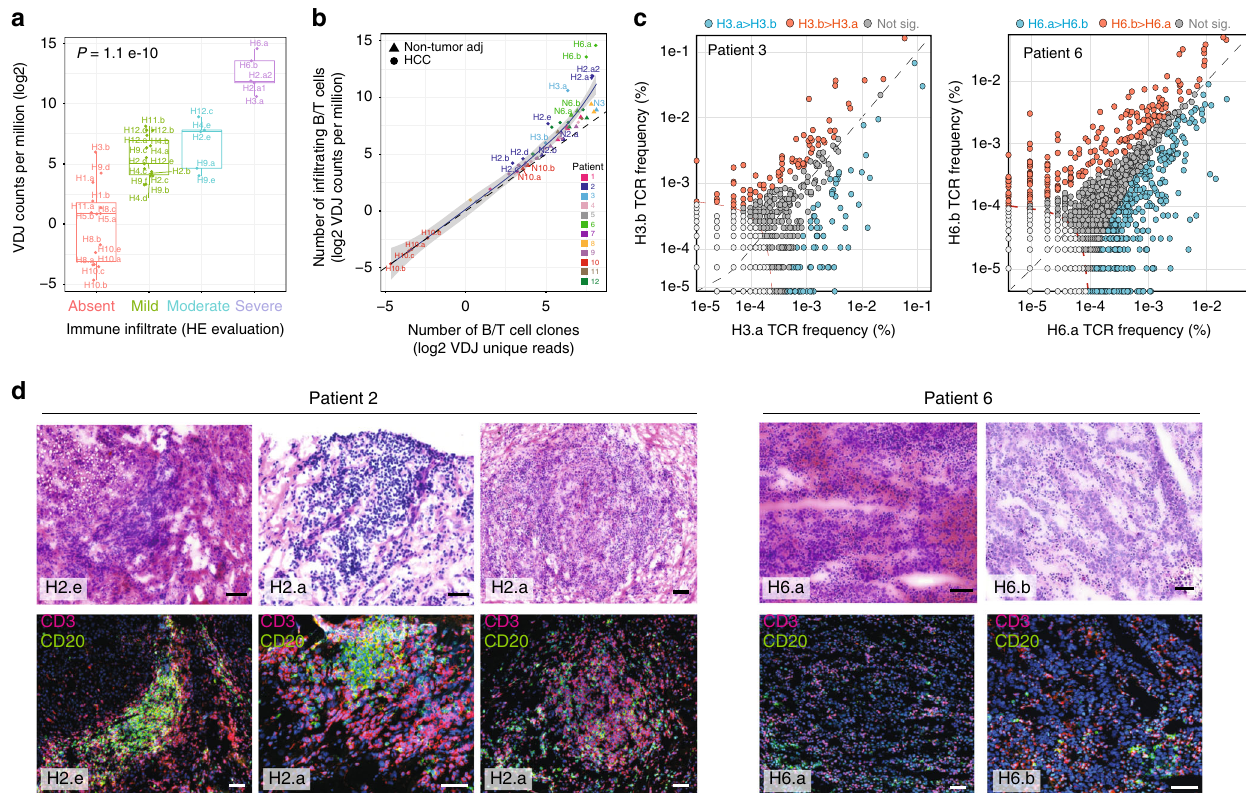
Fig. 2 Immunogenomic view of regional cancer-immune interactions in HCC and immune in fi ltrates. a Number of RNA-seq reads mapping to VDJ loci grouped by pathological immune in fi ltrate assessment (ANOVA, error bars = SE, N = 38 samples. For each boxplot, the centre line represents the median. Upper and lower limits of each box represent the 75th and 25th percentiles, respectively. The whiskers represent the lowest data point still within 1.5× box size of the lower quartile and the highest data point still within 1.5× box size of the upper quartile). b Number of RNA-seq reads mapping to VDJ as a function of the number of unique reassembled CDR3 sequences (i.e., number of unique immune clones). c Scatter plot of TCR rearrangement frequencies between tumoral regions of patient 3 and 6. TCR rearrangements found at signi fi cantly higher frequencies in region H3.a/H6.a than H3.b/H6.b are fi lled in blue. TCR rearrangements found at signi fi cantly higher frequencies in region H3.b/H6.b than H3.a/H6.a are fi lled in red. d Paired H&E and immuno fl uorescence of CD3 and CD20 in high TIL burden regions of P02 and P06 (CD3: Red; CD20: Green; black bar 100 µ m; white bar 50 µ m, N = 3 independent experiments). Source data are provided as a Source Data fi